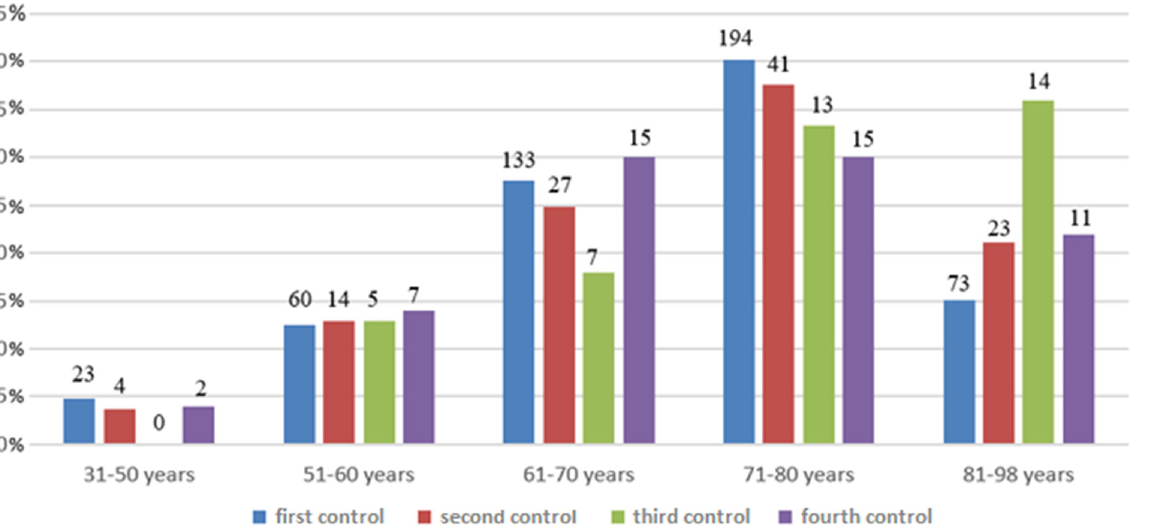
Figure 3. Concordance between epidemiologists and ward doctors (first control).